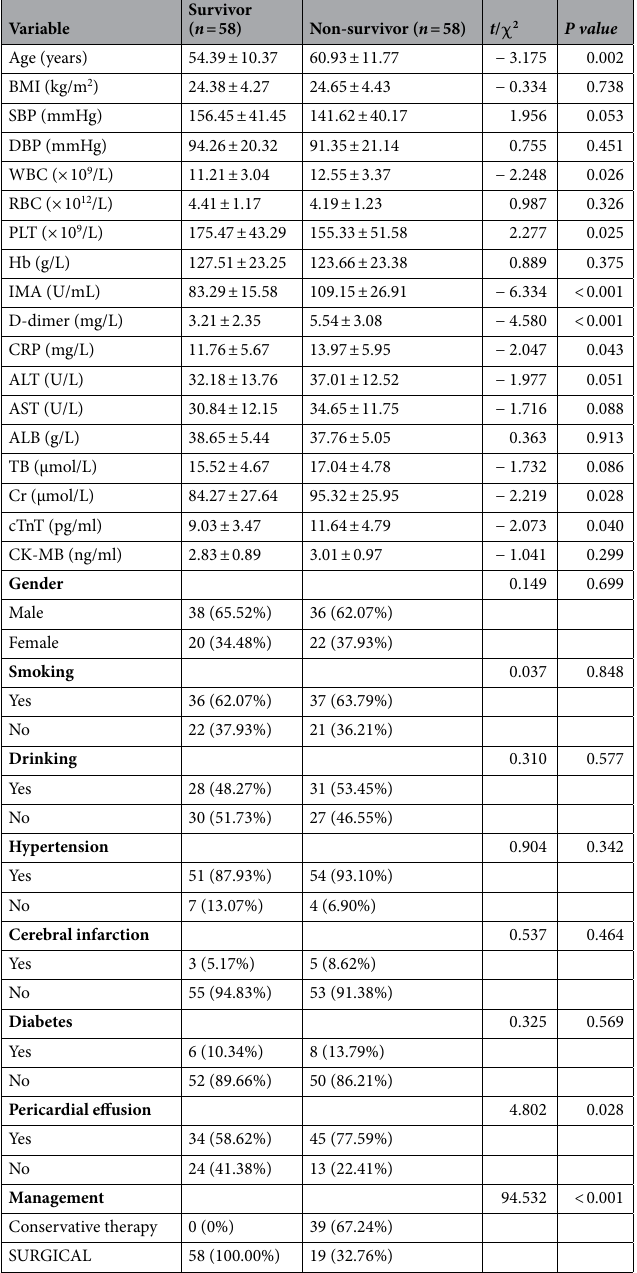
Table 2. Univariate analyses of variables associated with in-hospital mortality in TAAD. BMI, body mass index; SBP, systolic blood pressure; DBP, diastole blood pressure; WBC, white blood cell; RBC, red blood cell; PLT, platelets; Hb, hemoglobin; IMA, ischemic modified albumin; CRP, C-reactive protein; ALT, alanine transaminase; AST, aspartate aminotransferase; ALB, albumin; TB, total bilirubin; Cr, creatinine; cTnT, troponin T; CK-MB, creatine kinase MB; TAAD ,Stanford type A aortic